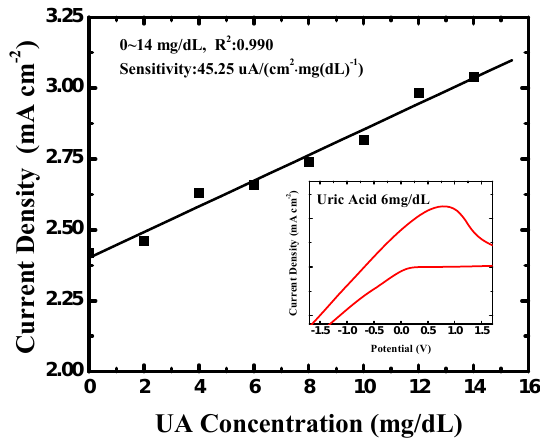
Figure 6. The CV measurement results of the uric acid biosensor.